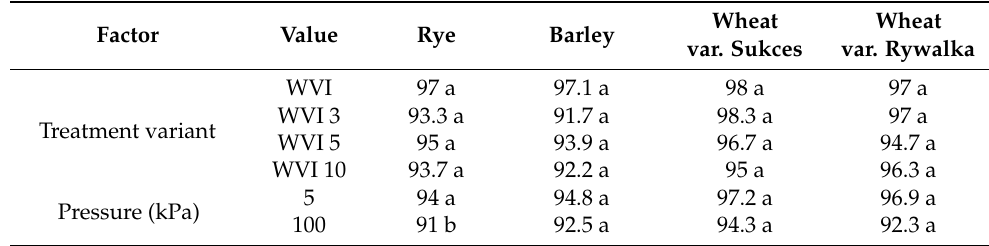
Table 1. Theanalysisofthesignificanceoftheinfluenceoftheexaminedfactorsonthegermination capacity A .